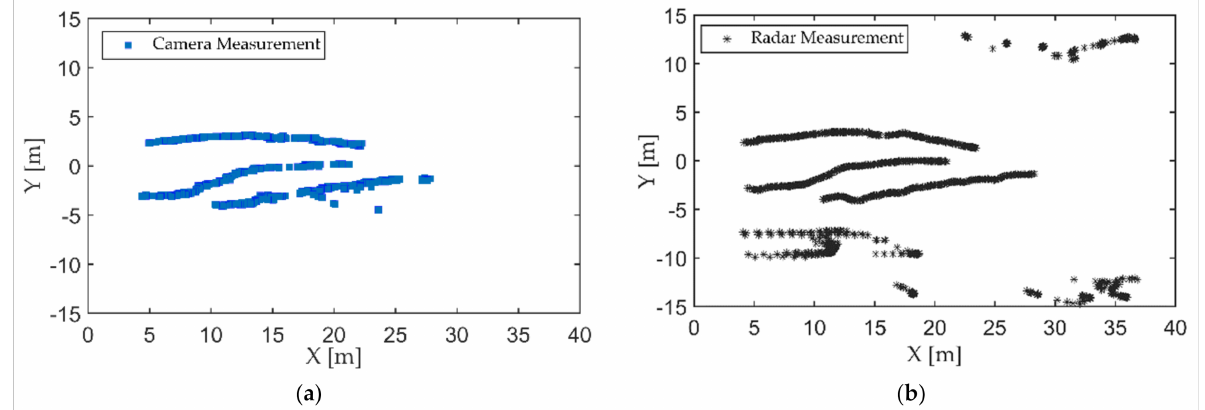
Figure 7. Detection results of targets: ( a ) camera; ( b )